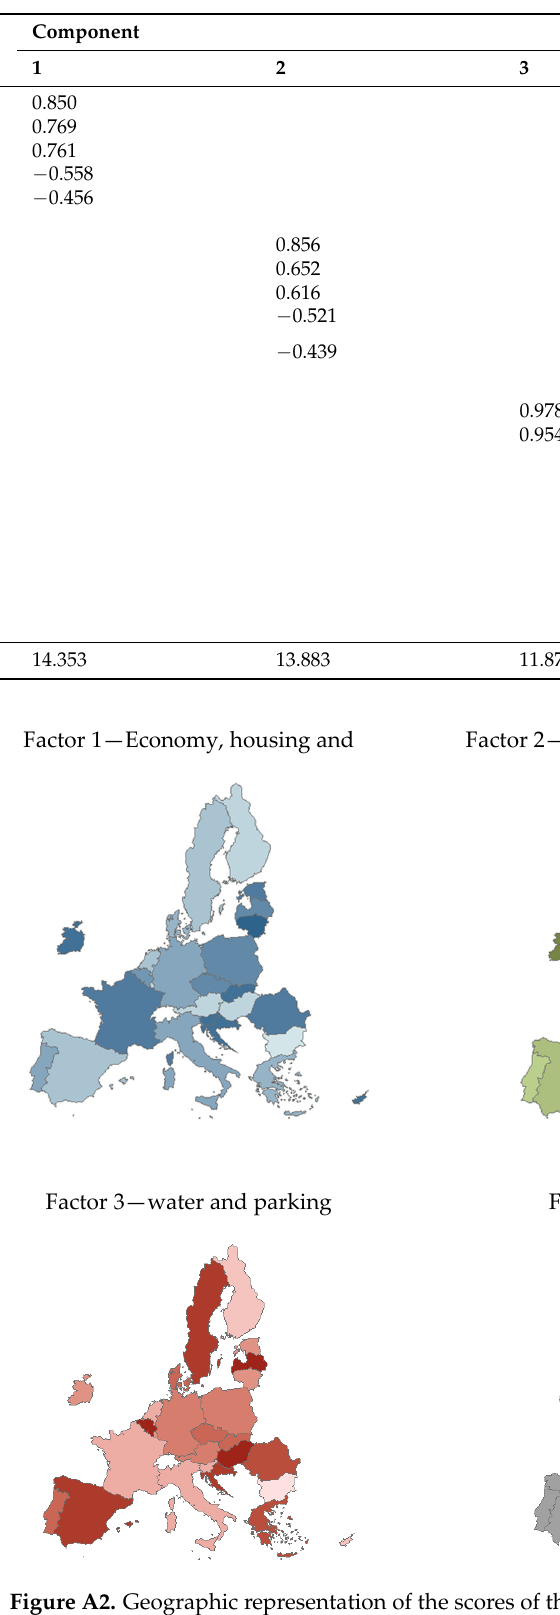
Table A4. Loadings of the principal component analysis (% of initiatives).